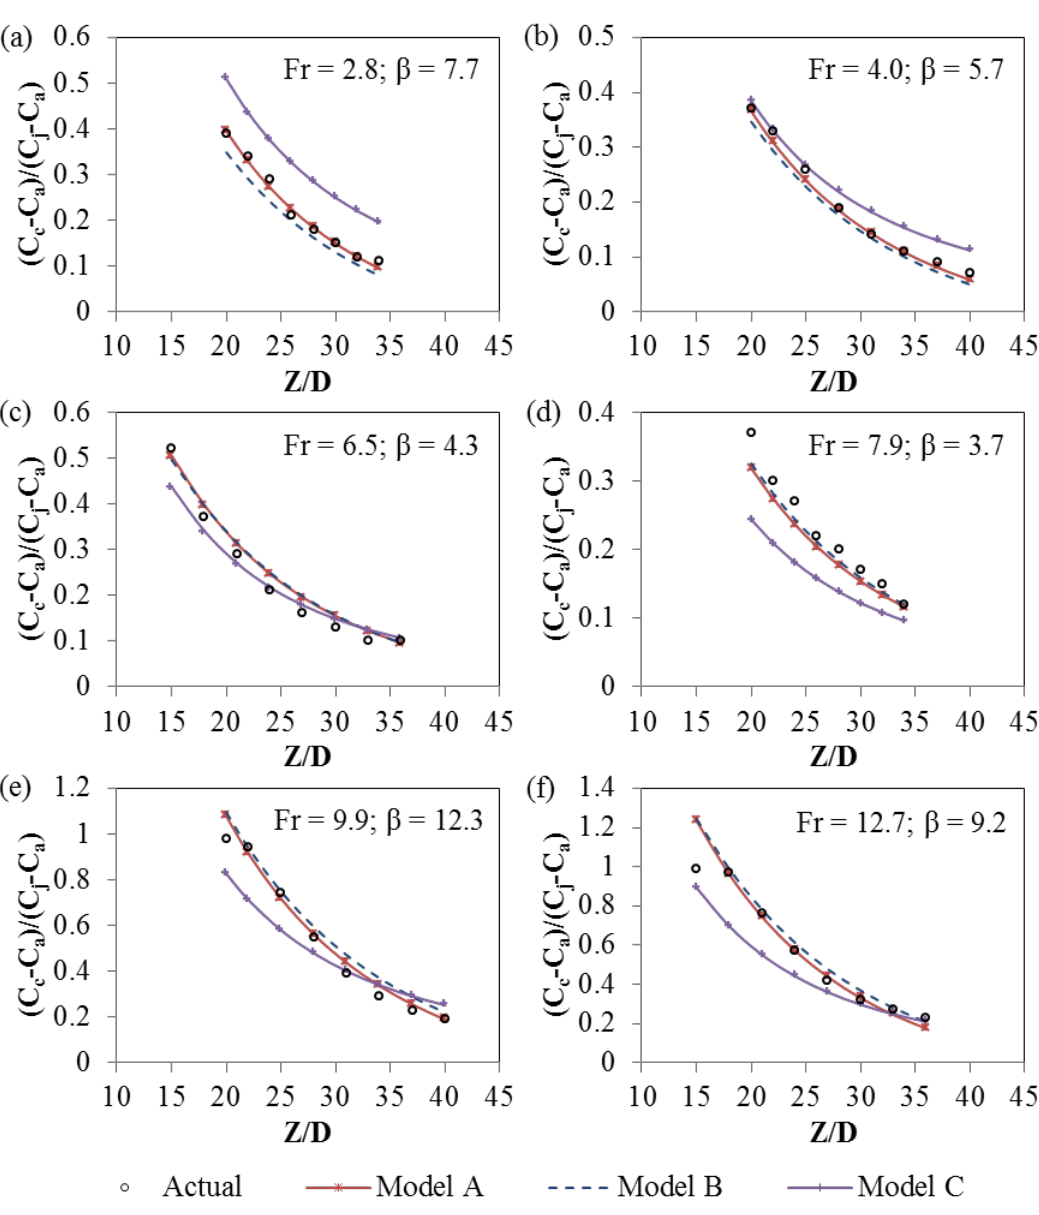
Figure 4. Actual and predicted concentration profiles: ( a ) Fr = 2.8; β = 7.7; ( b ) Fr = 4.0; β = 5.7; ( c ) Fr = 6.5; β = 4.3; ( d ) Fr = 7.9; β = 3.7; ( e ) Fr = 9.9; β = 12.3; and ( f ) Fr = 12.7; β = 9.2.